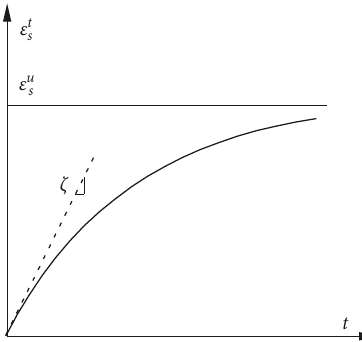
Figure 7: Relation curve ε t s and t under triaxial